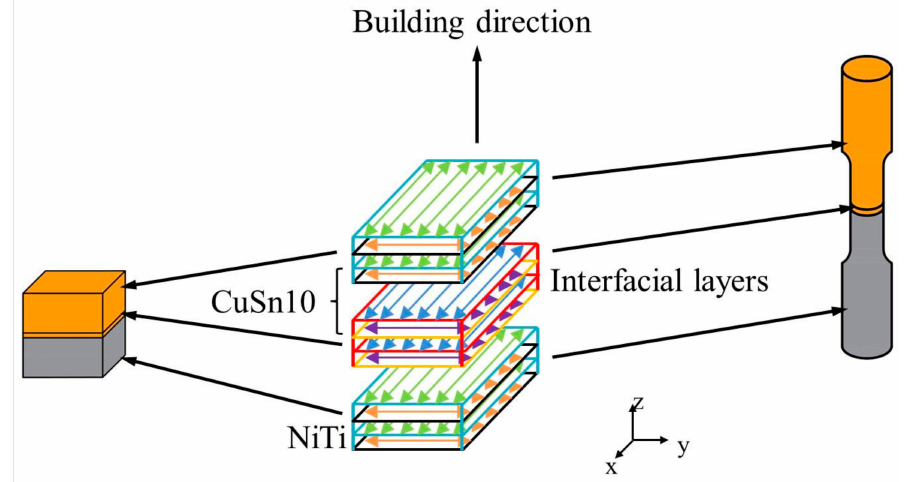
Figure 2. Diagram of forming the small cuboids and the tensile samples.